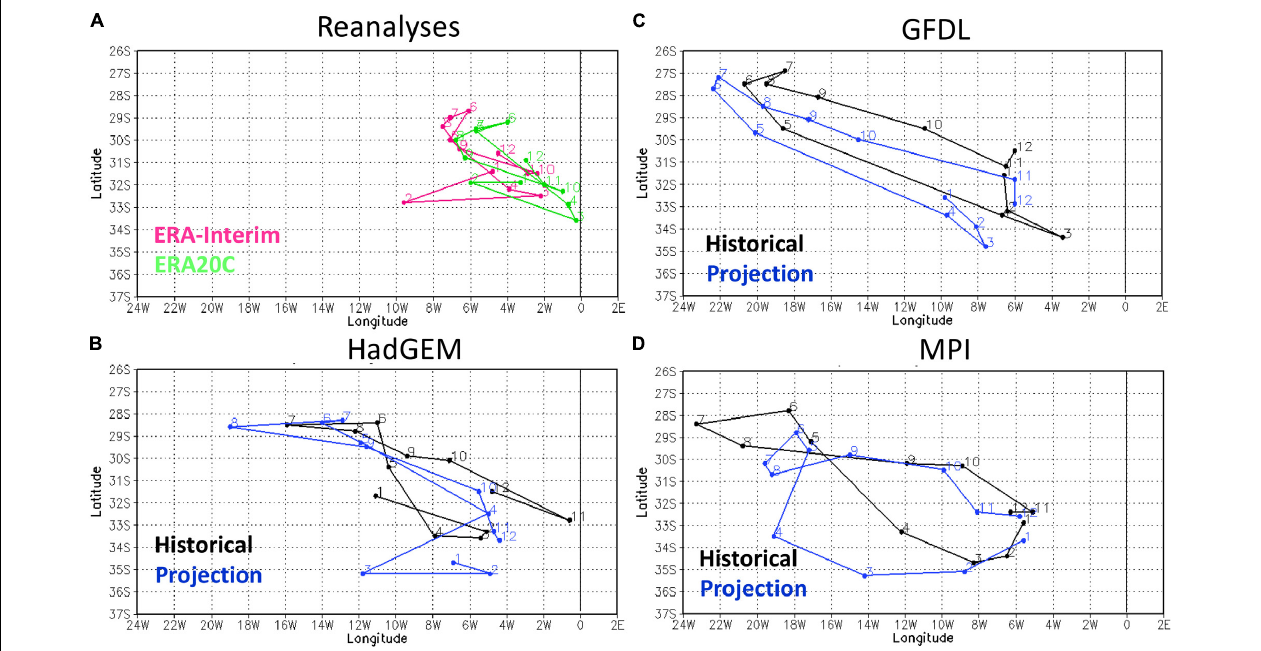
FIGURE 3 | Monthly climatology of the highest SASA pressure center position (latitude and longitude) in the present and future climates (black and blue lines, respectively) from (A) reanalyses (only for present), (B) HadGEM, (C) GFDL, and (D) MPI. Numbers from 1 to 12 refer to the months of the year and the vertical black line indicates the longitude 0 ◦